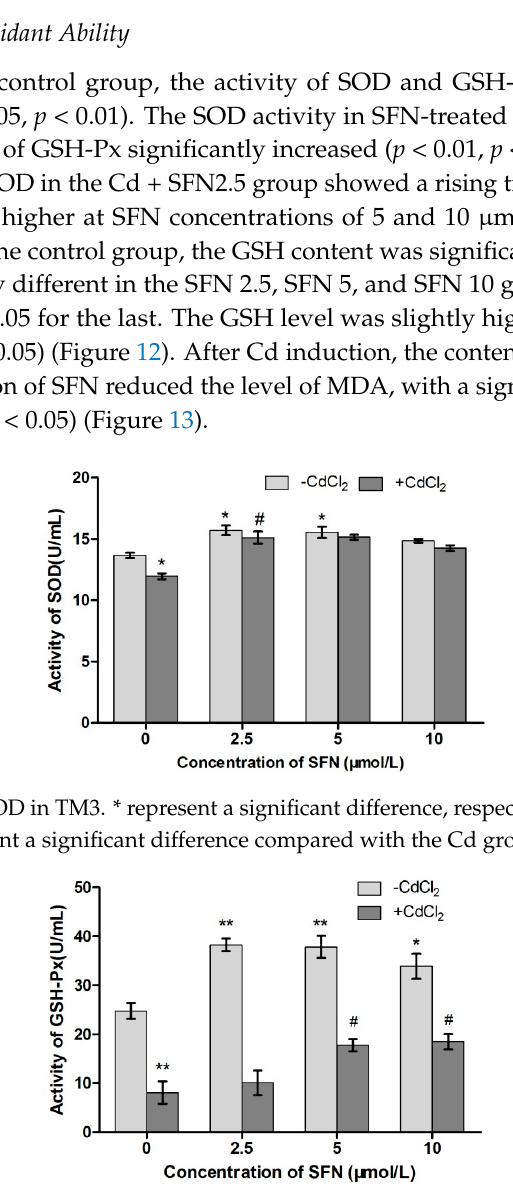
Figure 11. Activity of GSH-PX in TM3. * and ** represent a significant and an extremely significant difference, respectively, compared with the control group. # represent a significant difference compared with the Cd group.